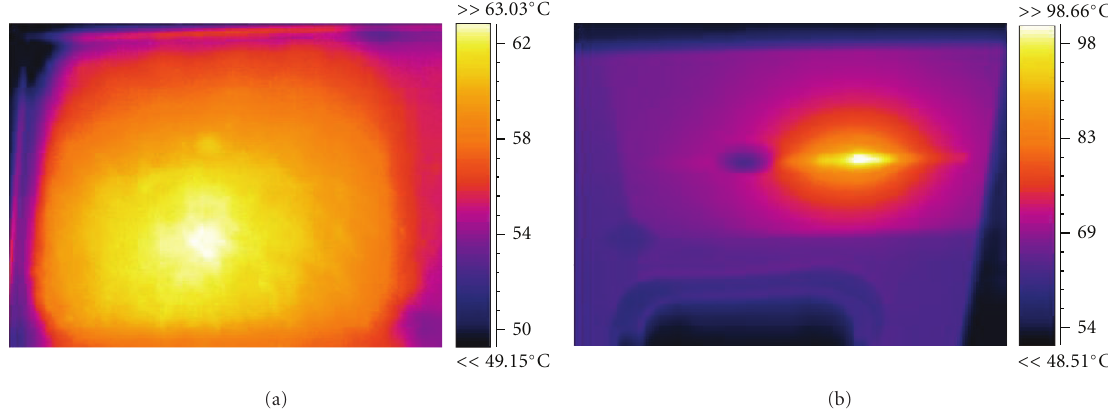
Figure 8: IR image (a) front and (b) back, of the cell displayed in Figure 7, exhibiting a large hot spot area at the front and increased temperature on the bus bar and blister at the back.